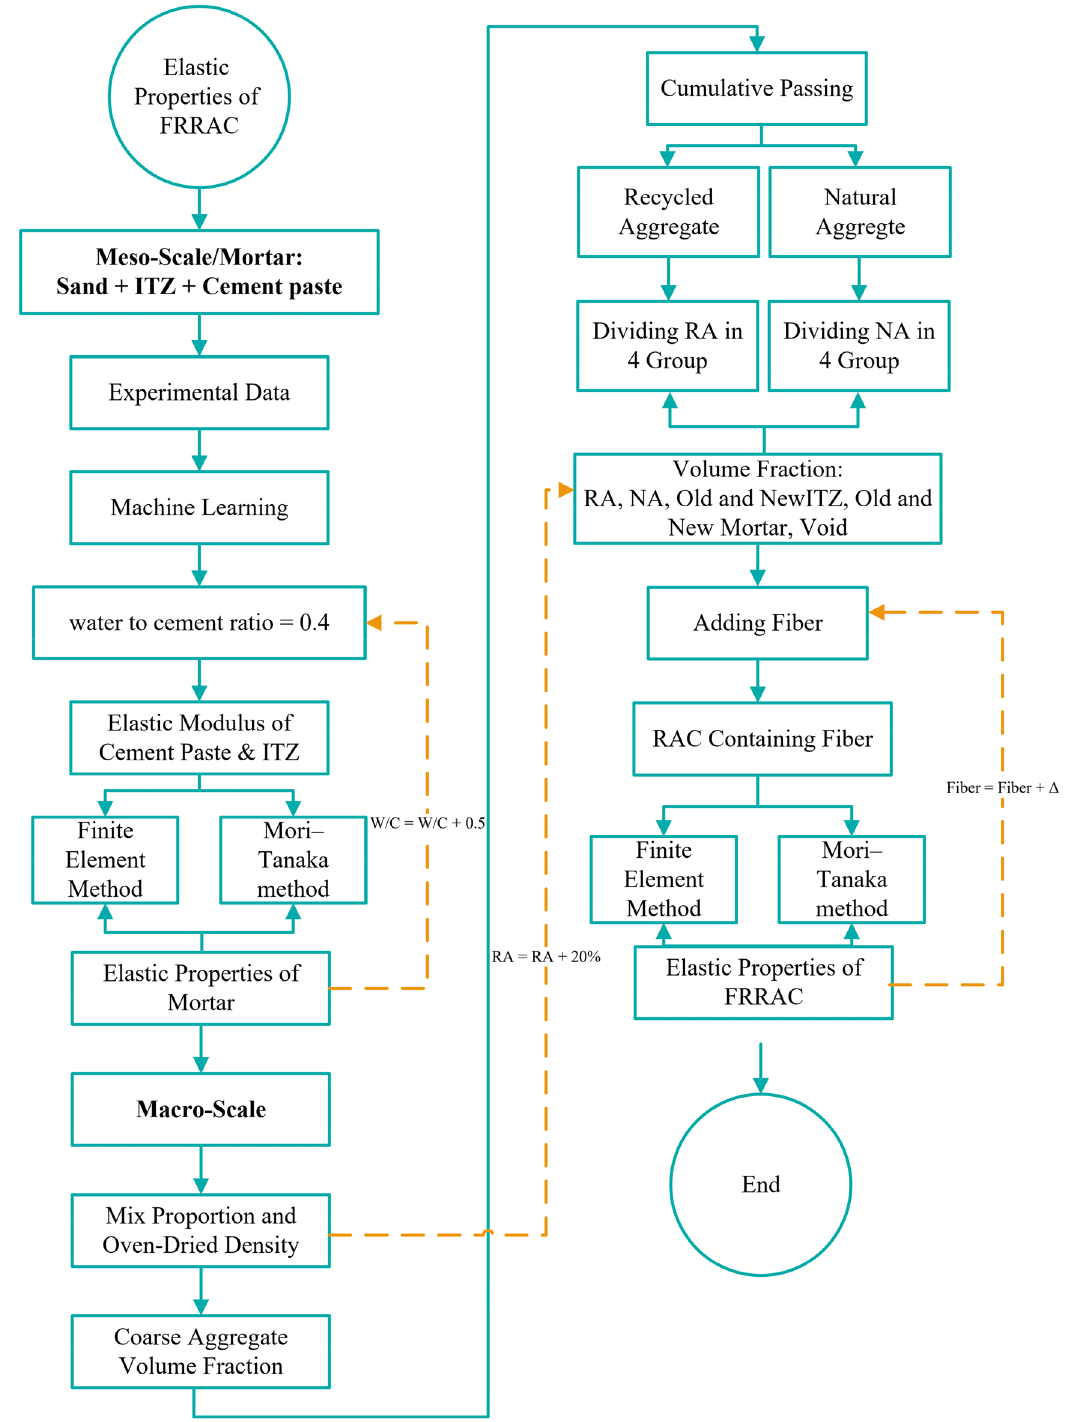
Figure 2. The overall flowchart of the proposed multi-scale modeling